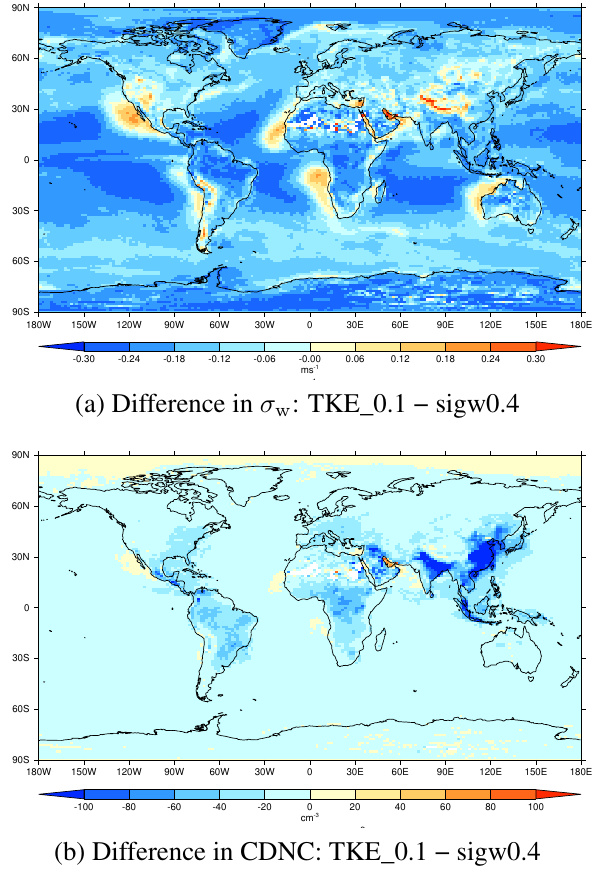
Fig. 5 : Annual mean in-cloud λ calculated from w ∗ = λσ w from model configuration sigw0.4